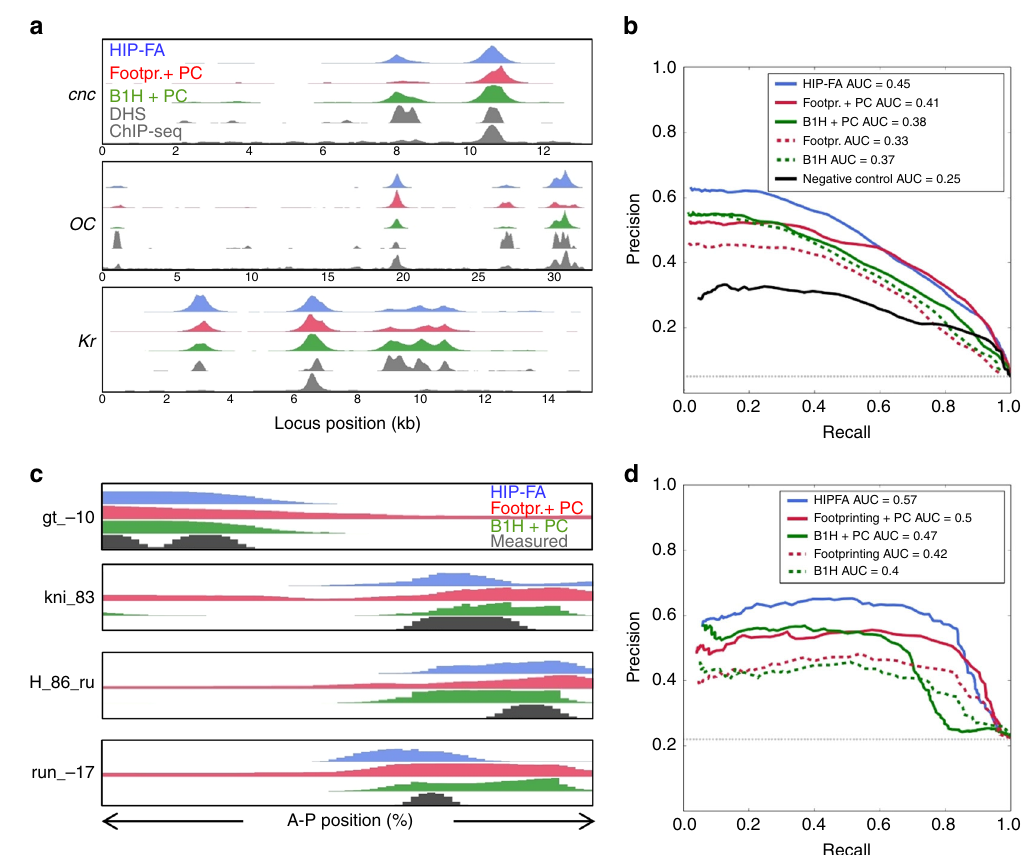
Fig. 4 Performance of HIP-FA PWMs (blue), compared to footprinting (red) and B1H (green) PWMs in TF occupancy prediction tasks. The addition of pseudo-counts (PC) is bene fi cial for footprinting and B1H, but not for HIP-FA PWMs. a Prediction of the ChIP-Seq peaks for Bcd in the genomic regions of cnc , oc , and Kr , based on the predicted binding sites and the DNA accessibility (DHS) information, compared to measured ChIP-Seq data. For the prediction, we identi fi ed all TF binding sites and their relative strength using PWM and accessibility information, and then applied a gamma function to mimic the fragment length distribution in the ChIP-Seq experiment. b Precision – Recall plot for the ChIP-Seq peak predictions over 20 segmentation loci. Each point represents a threshold for the peak prediction; the thin gray line indicates the precision of a random guess. The area under curve (AUC) scores indicate the overall quality of the predictions. c Predicted expression patterns based on TF binding site content for four representative segmentation cis -regulatory elements, compared with the measured patterns. Shown are relative expression levels from 80% to 20% egg length along the antero-posterior axis of Drosophila blastoderm embryos. d Precision – Recall plot and AUC scores for the pattern predictions of all 37 cis -elements, as in